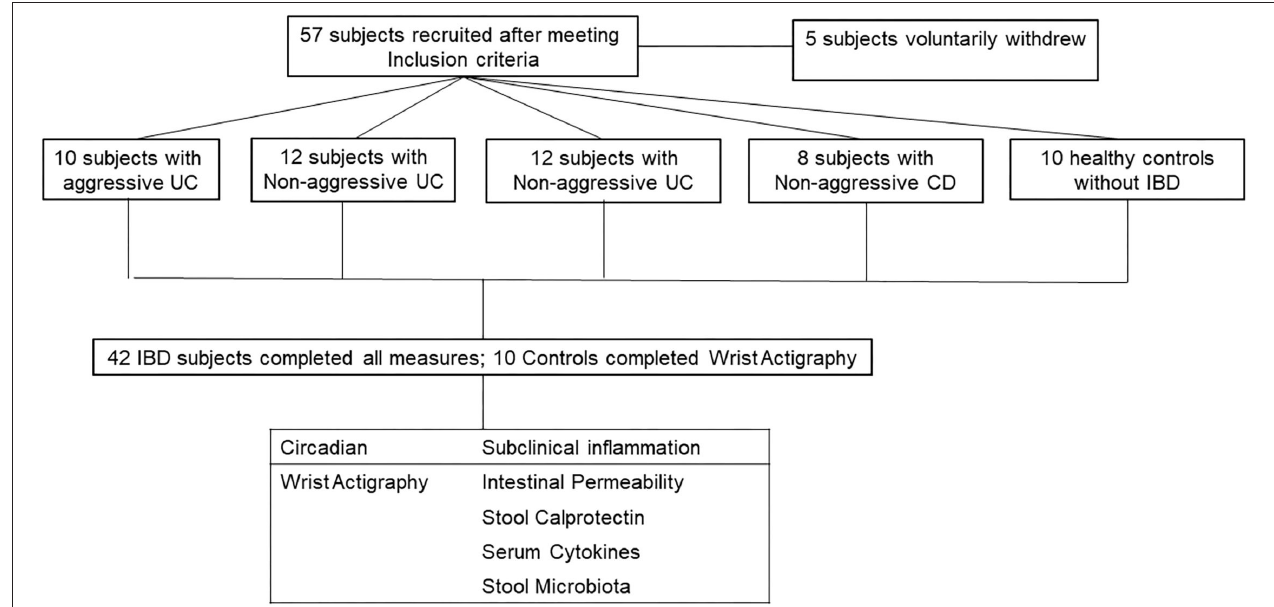
FIGURE 1 | CONSORT flow diagram. 57 subjects were recruited into the study. 5 voluntarily withdrew and did not complete all measures. The 52 subjects who completed all measures, were divided into two categories (Circadian and Subclinical Inflammation). Healthy controls only completed circadian measures as they should have no subclinical inflammation.